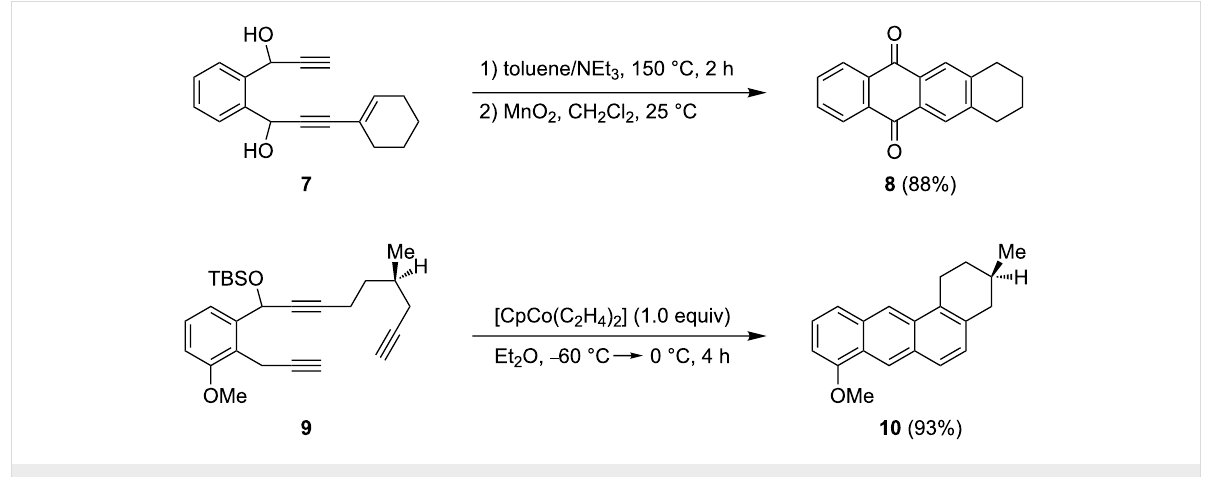
Scheme 2: Synthesis of simplified anthracycline derivatives.